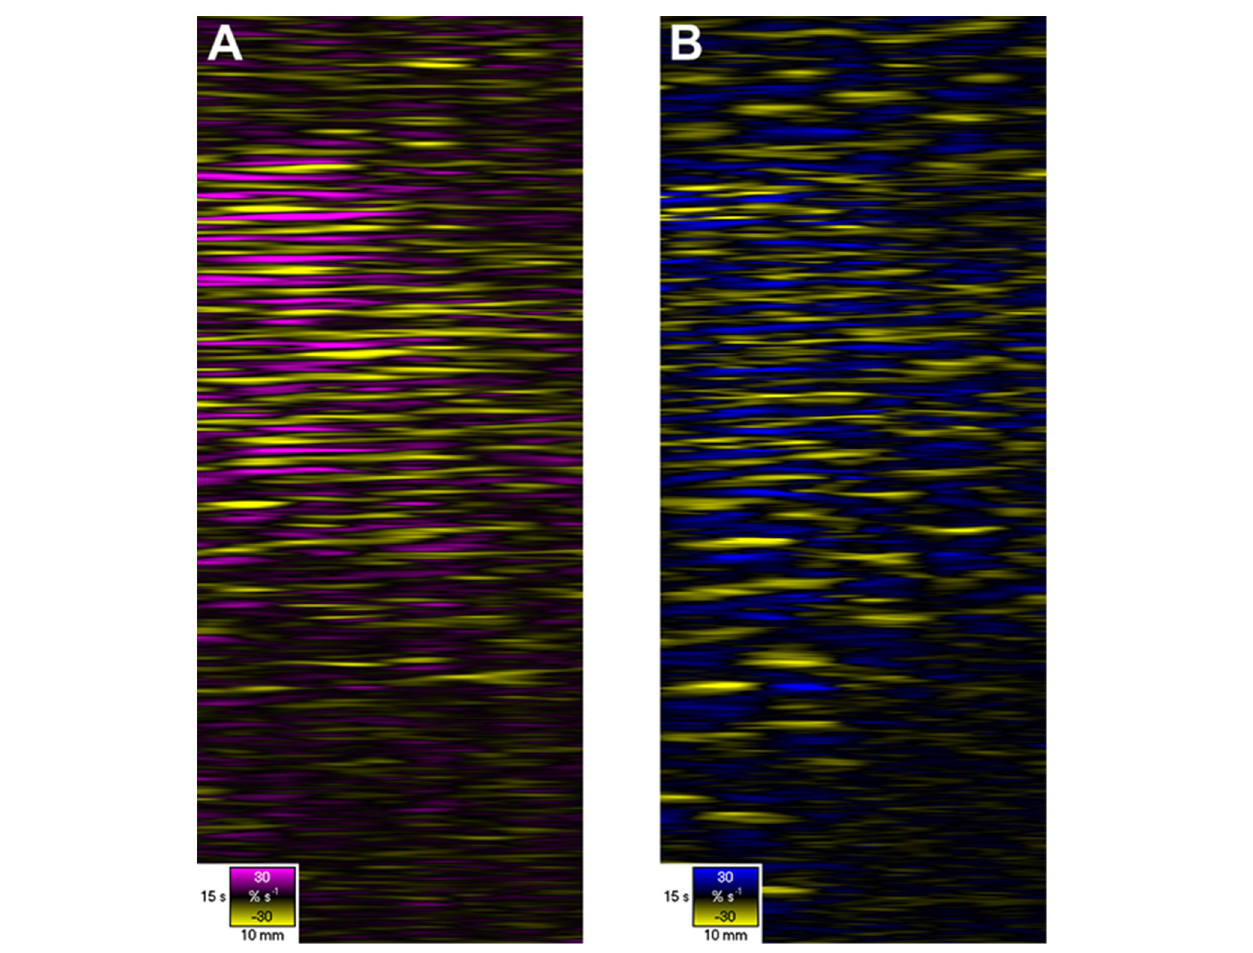
FIGURE 6 | D- and L-type ST Maps showing variation in circumferential (A) and longitudinal (B) strain rate in the terminal ileum of the pig in situ at laparotomy, before and after dosage with remifentanyl. The markers are the vascular arcades which are prominent in vivo . Areas of circular (A) and longitudinal (B) contraction (–ve strain rate) are shown in yellow and areas of circular and longitudinal relaxation in purple and blue respectively (note color codes and magnitudes at the base of each map). Note that the contractions i.e., the discrete patterns of negative circular (A) and longitudinal (B) strain rate typical of segmentation ( Figure 5 ) in the upper region of the D- and L-type STmaps briefly become aligned i.e., in staggered phase, during the period after the administration of Remifentanyl. Hence the contraction appears to propagate along the length of the ileum. Figure adapted from Janssen et al.